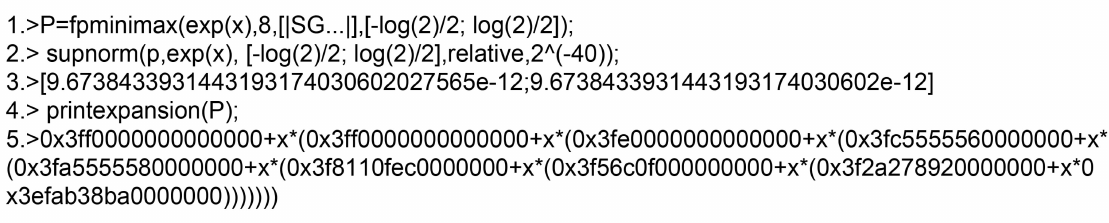
Figure 3. The min-max polynomial generation process of the exp